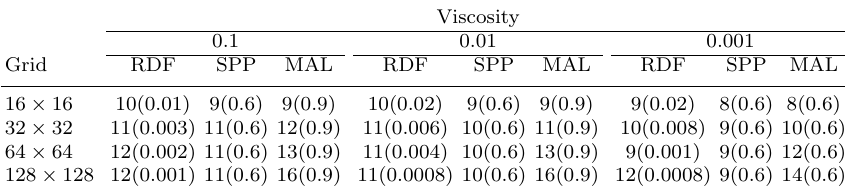
Table 6. Number of GMRES(20) iterations with the RDF, MAL and SPP preconditioners for unsteady Oseen problems (Q2-Q1 FEM uniform grids). The parameters τ , α , γ are experimentally optimal.